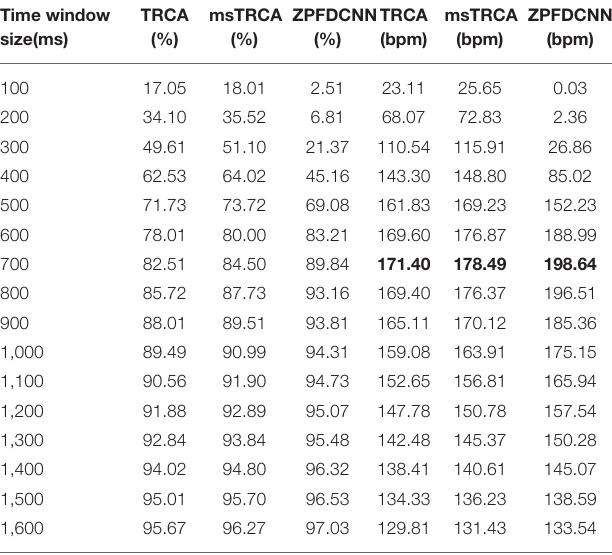
TABLE 3 | Average classification accuracy and ITR of SSMVEP dataset with a visual shift time of 0.55 s.